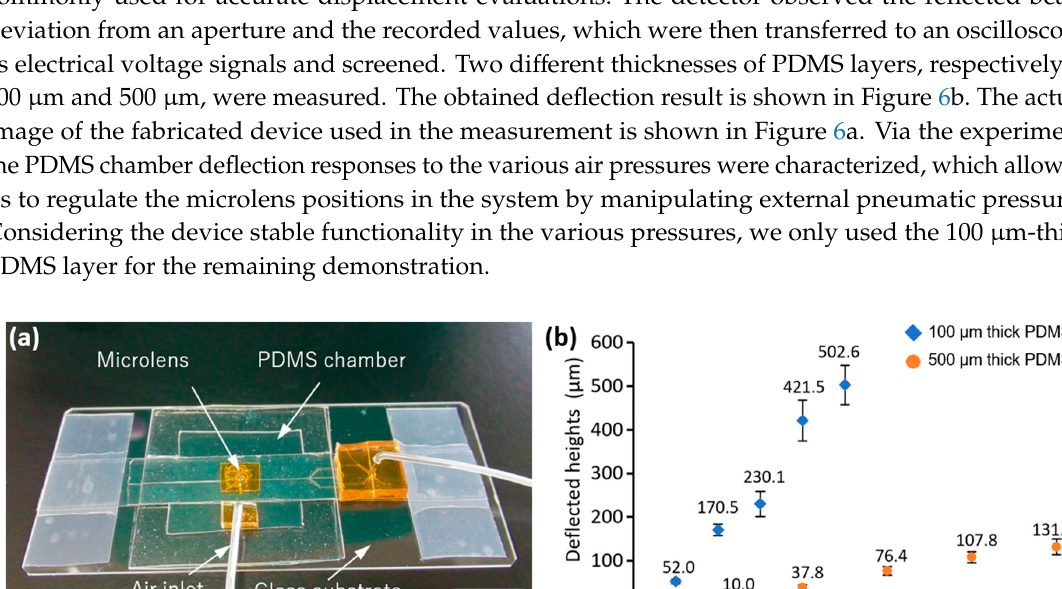
Figure 7. The on-chip optical system and some experimental results. ( a ) The device setup under the microscope; air pressure was supplied into the PDMS chamber via the tube marked by the red arrow. The green arrow points to the tube with fluorescent microbeads flowing into the microchannel. ( b ) The device assembly. ( c ) Images of the microscope focus calibrated on the glass chip. ( d ) Microbeads